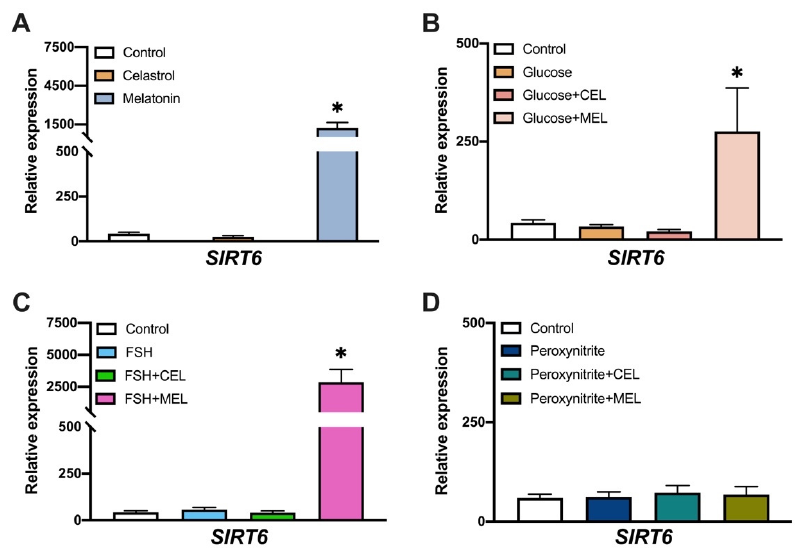
Figure 4. Effect of glucose, peroxynitrite, FSH, celastrol (CEL), melatonin (MEL) and their combinations on SIRT6 gene expression. SIRT6 relative expression levels in hGL cells treated with: ( A ) celastrol ( n = 19) or melatonin ( n = 18), ( B ) glucose ( n = 17) and in combination with celastrol ( n = 19) or melatonin ( n = 18), ( C ) FSH ( n = 17) and in combination with celastrol ( n = 19) or melatonin ( n = 18), ( D ) peroxynitrite ( n = 20) and in combination with celastrol ( n = 18) or melatonin ( n = 17). Asterisks (*) indicate statistically significant differences compared to control.